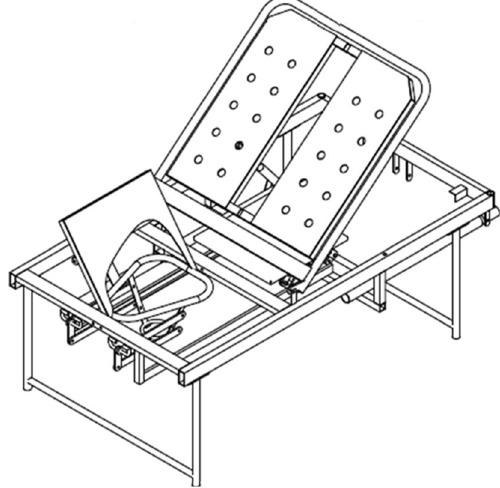
Fig. 7 Raised side and raised backrest position